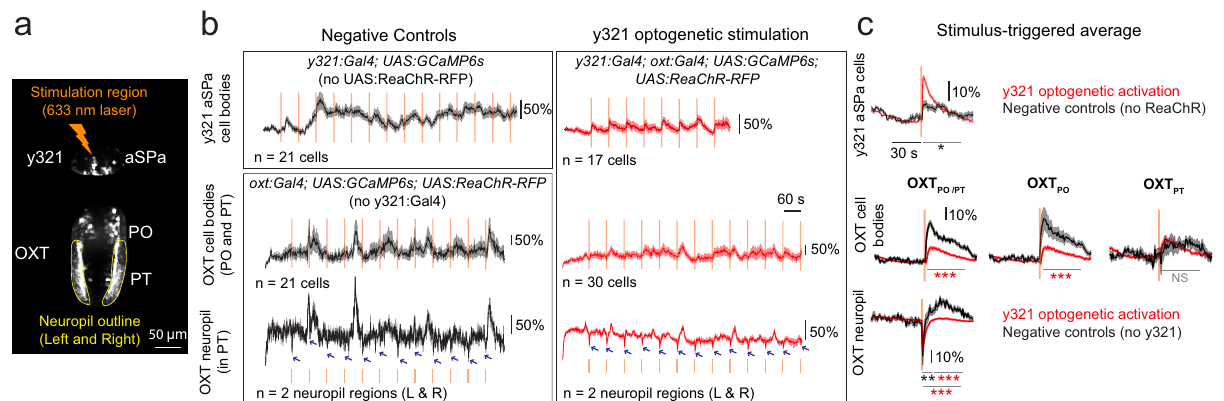
Fig. 5 Optogenetic stimulation of subpallial neurons suppresses OXT activity. a Maximum-projection image showing regions of optogenetic stimulation (aSPa y321 neurons) and calcium imaging (OXT neurons in PO or PT, or neuropil bundles in PT outlined in yellow). This experiment was repeated on 18 fi sh with similar results. b Mean Δ f/f traces from either aSPa y321 neurons or OXT cell bodies/neuropil bundles after stimulation with a 633 nm laser focused on the aSPa region at 60-s intervals. Black traces depict mean Δ f/f of an example ReaChR-negative-control fi sh (top) or y321-negative-control fi sh (bottom). Red traces depict mean Δ f/f from an example Tg(y321:Gal4, oxt:Gal4; UAS:GCaMP6s; UAS:ReaChR-RFP) fi sh of its aSPa y321 neurons (top), OXT PO/PT cell bodies (middle), or neuropil (bottom), subject to aSPa y321 optogenetic stimulation. Orange lines indicate stimulus onset. Each box represents calcium traces from an individual representative fi sh. Shaded region indicates SEM. Blue arrows indicate dips in OXT neuropil activity in the presence or absence of optogenetic y321 activation. c Stimulus-triggered averages showing the mean Δ f/f before and after the light stimulus. Responses to each stimulus were fi rst averaged per unit (cell body or neuropil bundle) before being averaged across all units to obtain the Δ f/f trace. Shaded region indicates SEM. Two-sided Wilcoxon rank-sum test was used for all statistical comparisons. Top panel: The calcium response ( Δ f/f) of aSPa y321 neurons to 633 nm laser stimulation is signi fi cantly higher in the presence (red, n = 320 neurons from 15 fi sh) than absence (black, n = 118 neurons from 4 fi sh) of ReaChR (* p = 0.031). Middle panel: The calcium response of OXT PO/PT neurons under aSPa y321 optogenetic stimulation is signi fi cantly lower (*** p = 5.4×10 − 6 , n = 410 neurons from 18 fi sh) than for negative controls ( Tg(oxt:Gal4; UAS:GCaMP6s; UAS:ReaChR-RFP) fi sh) exposed to the same light stimulus ( n = 103 neurons from 5 fi sh). When we separated these OXT neurons according to their anterior – posterior position, we found that OXT PO neurons showed signi fi cant suppression after aSPa y321 optogenetic stimulation compared with negative controls (*** p = 0.00028, n = 294/91 neurons), but no signi fi cant difference was observed for OXT PT neurons (OXT PT ; p = 0.198, n = 116/12 neurons). Bottom panel: OXT neuropil calcium responses under y321 optogenetic stimulation are overall signi fi cantly lower than for negative controls exposed to the same light stimulus (*** p = 2.7×10 − 5 , n = 36/10 neuropil regions). The dip in neuropil activity under y321 stimulation is signi fi cantly less negative than the negative controls in the fi rst 10-s epoch (** p = 0.0094), whereas neuropil activity is signi fi cantly lower than the negative controls in the next 30-s epoch (*** p = 2.4×10 − 5 ). Gray bars indicate the 40-s period across which Δ f/f was integrated for statistical analysis; asterisk color re fl ects the group with the more negative (i.e., lower) integrated value. Source data are provided as a Source Data fi